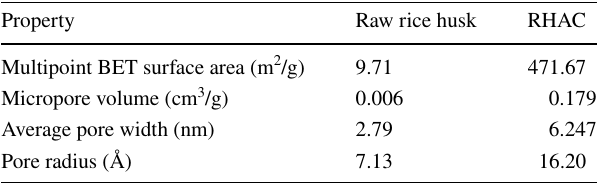
Table 4 BET surface area and pore size distribution of raw rice